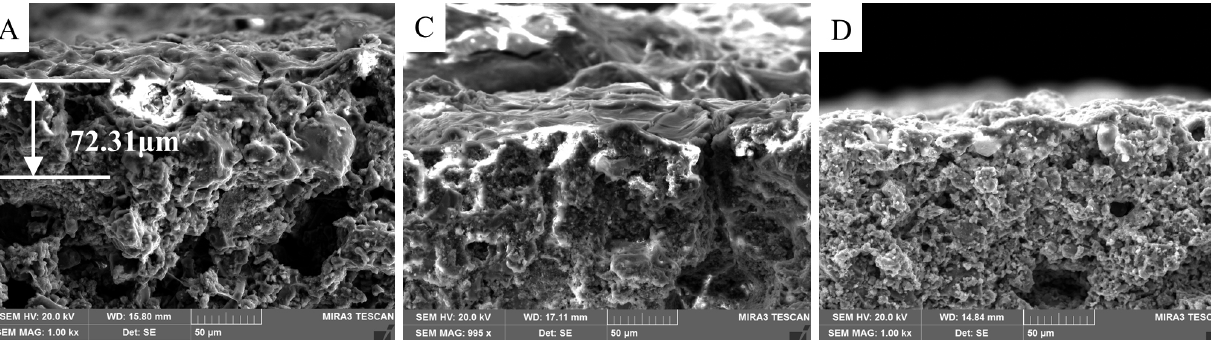
Figure 2. SEM images on the cross section of the top surface of specimen A, C,